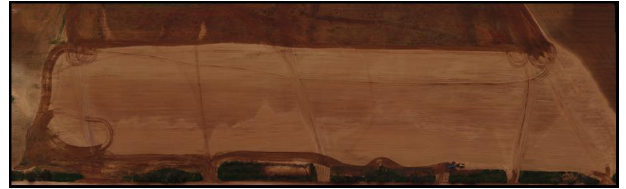
Figure 2: Aerial image of Site 1, the base of a subsoil stockpile at WRP Mine site.